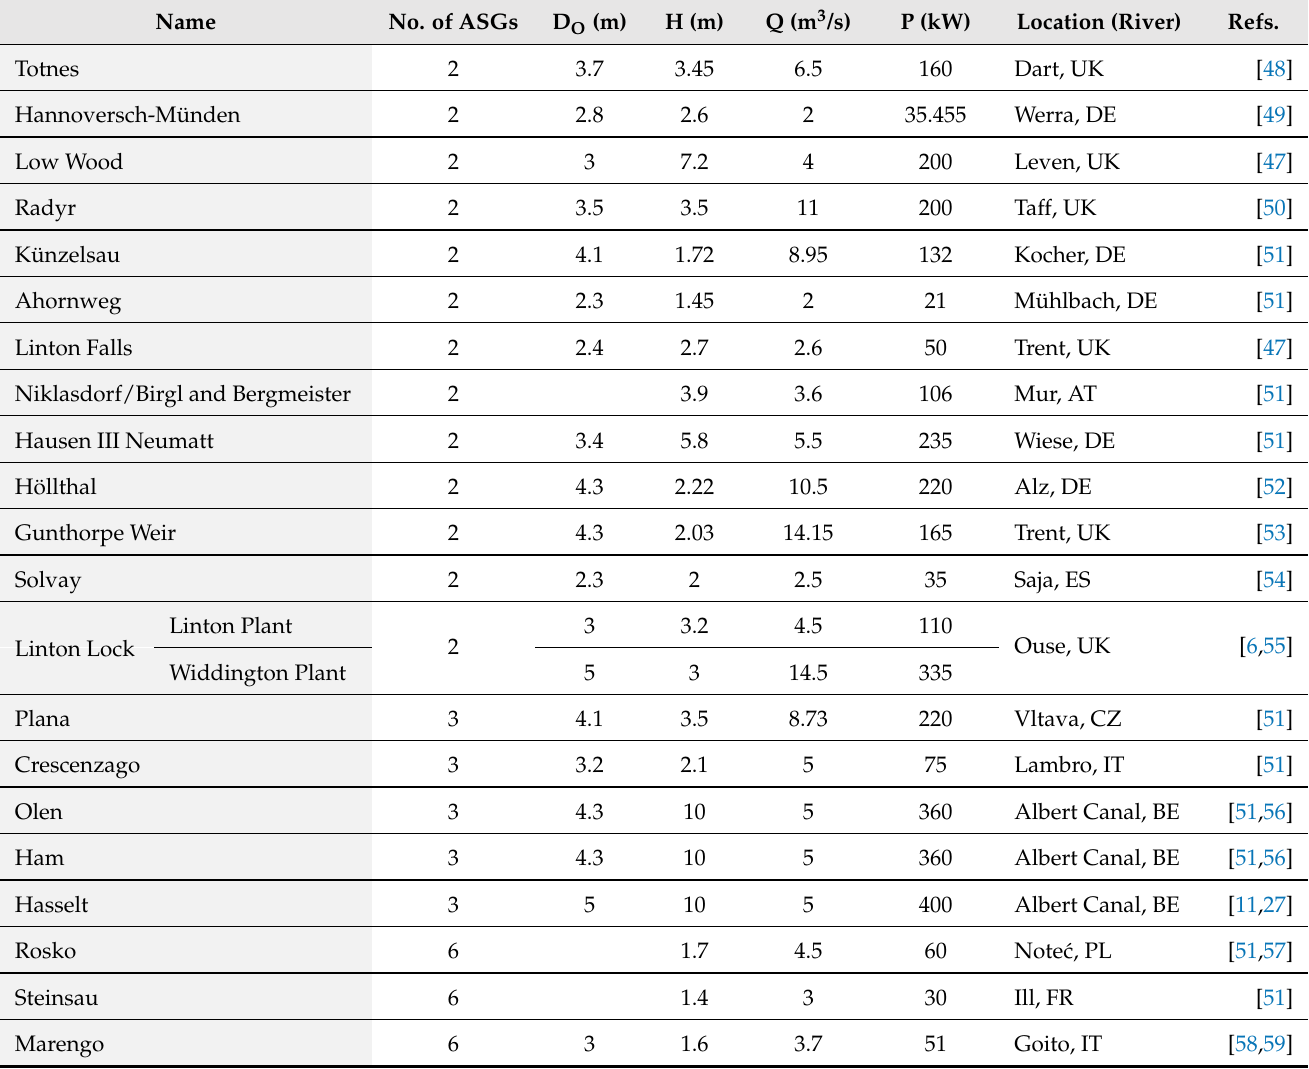
Table 2. Hydropower plants using several parallel Archimedes screw turbines. All screws at a plant are identical unless otherwise noted. Power and flow values are for a single screw at the plant: multiply by the number of screws for total plant flow and